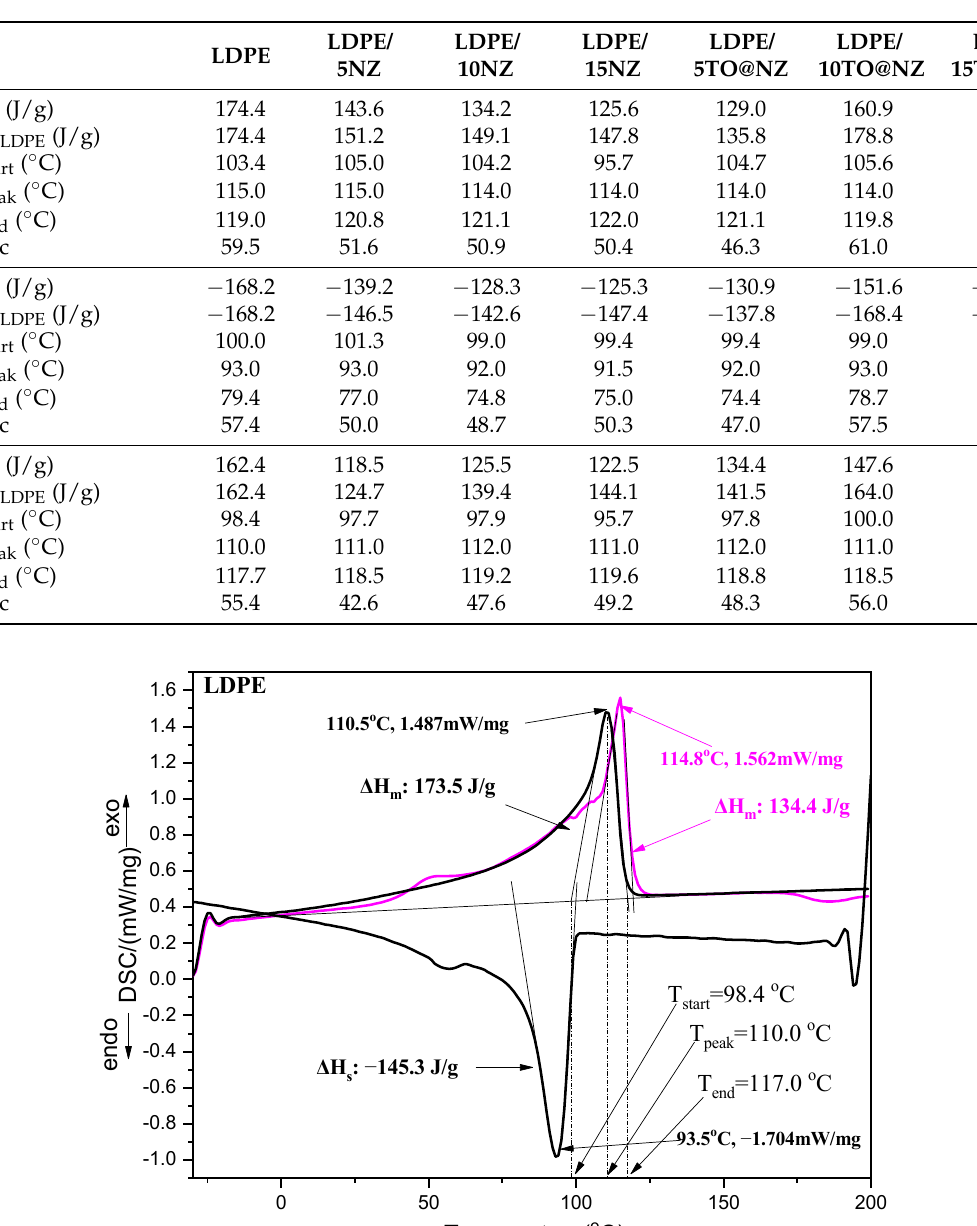
Table 1. Calculated values of enthalpies ( ∆ H), temperatures (T start , T peak, T end ), and degree of crystallinity (%Xc) for the melting 1, melting 2, and crystallization processes of all LDPE/xNZ and LDPE/15TO@NZ films, as well as pure LDPE film for comparison.